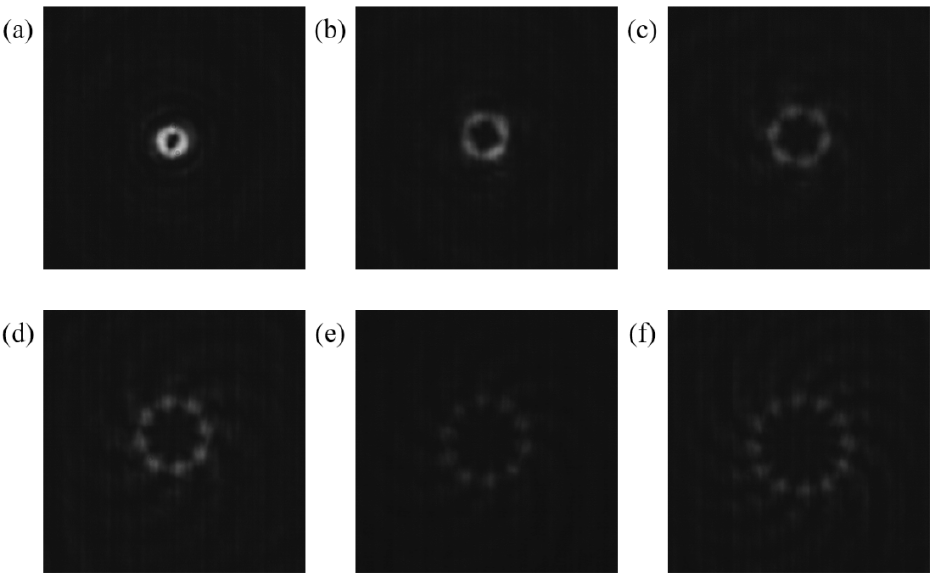
Figure 13. Measured diffraction patterns for the CSZPG with ( a ) l = 2, ( b ) l = 4, ( c ) l = 6, ( d ) l = 8, ( e ) l = 10 and ( f ) l = 12, respectively.